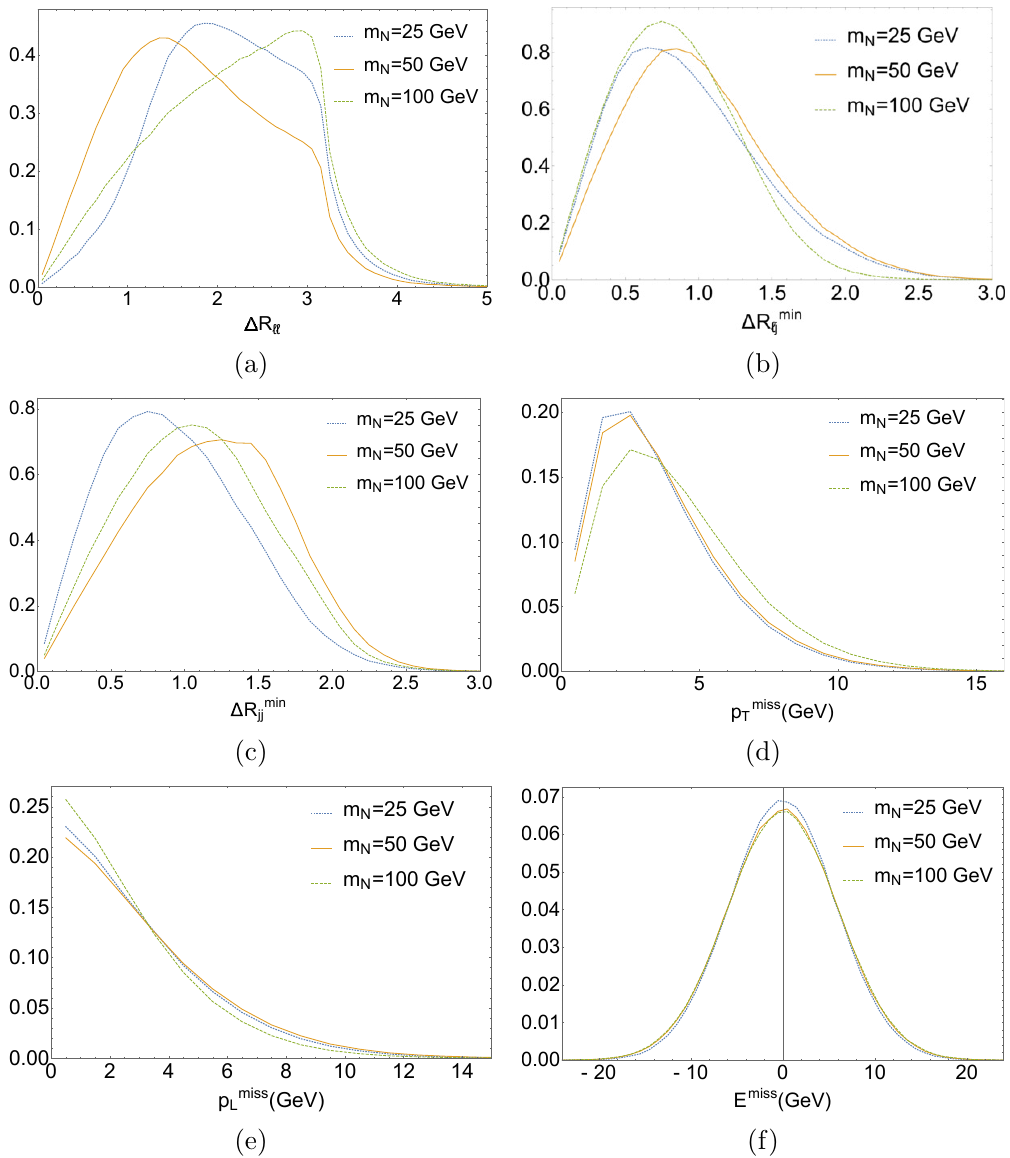
Figure 4 . Normalized distributions (cid:27) (cid:0) 1 d (cid:27)= d X for m N = 25, 50 and 100 GeV at the CEPC for (a) the radial isolation of muon pairs (cid:1) R ‘‘ ; the minimal radial isolation (b) (cid:1) R min (d) the missing transverse momentum =p missing total energy =E . The missing total energy is the c.m. energy 250 GeV minus the sum of energies of all visible particles in the (cid:12)nal